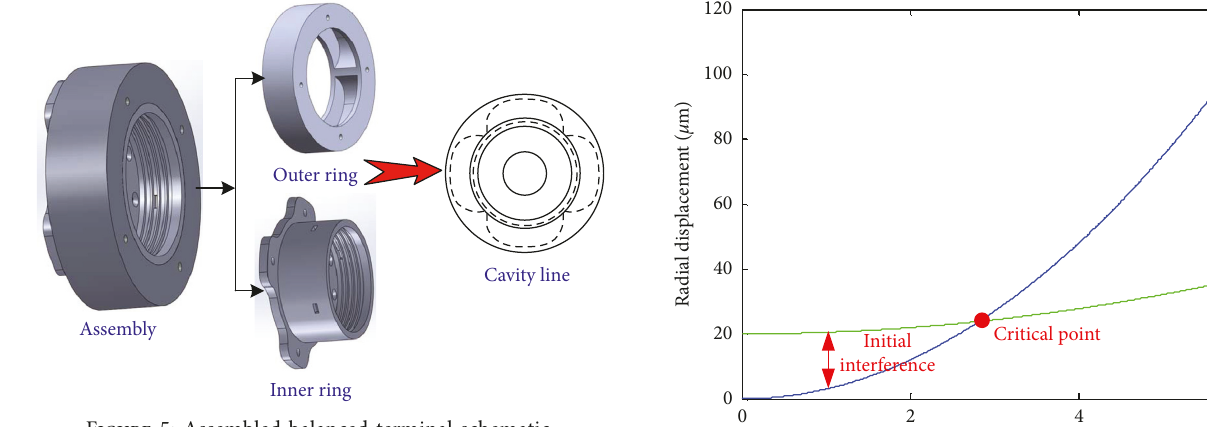
Figure 5: Assembled balanced terminal schematic.